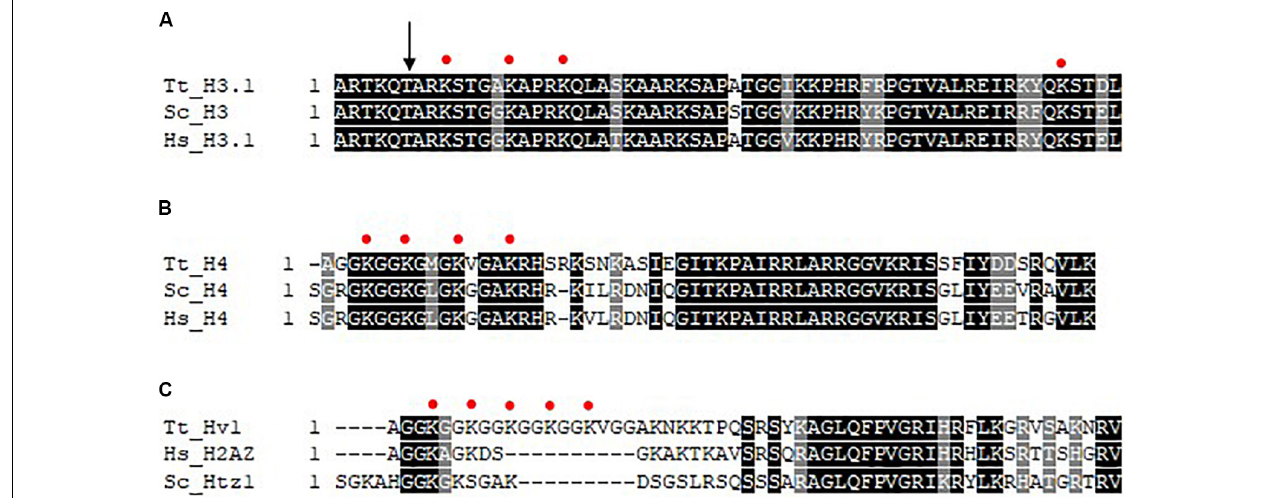
FIGURE 2 | Multiple sequence alignment of histone N-termini. Clustal Omega was used to perform multiple sequence alignment (EMBL-EBI) and shaded using BoxShade (ExPASy). Absolutely conserved residues are represented by a black shade and conserved residues are represented by a gray shade. Red circles represent sites of acetylation as indicated in the text. (A) N-termini of histone H3. The arrow indicates site of N-terminal proteolysis. (B) N-termini of histone H4. (C) N-termini of histone H2A variant Hv1/H2AZ. Tt, Tetrahymena thermophila ; Hs, homo sapiens ; Sc, Saccharomyces cerevisiae